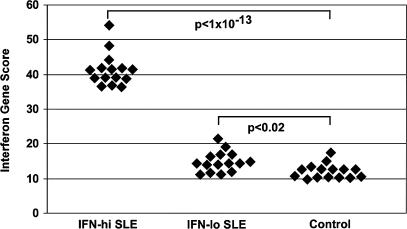
IFN Gene Expression Scores for IFN-hi SLE, IFN-lo SLE, and Control ParticipantsWhole blood gene expression microarrays were used to identify 82 type I IFN-regulated genes that distinguished 81 SLE cases from 42 controls. From these genes, a normalized IFN gene score was derived. Plotted are IFN gene scores for 15 IFN-hi SLE (mean ± SD, 41.0 ± 4.8), 15 IFN-lo SLE (14.4 ± 2.8), and 15 controls (12.1 ± 1.9).